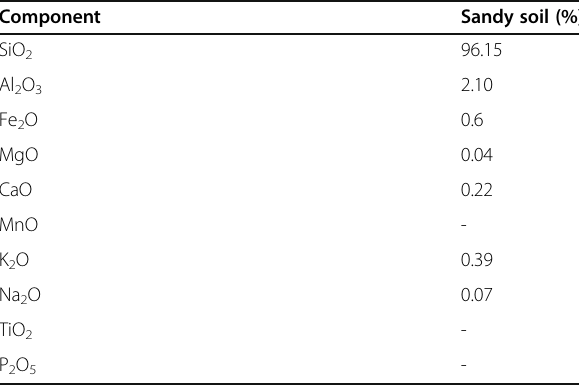
Table 2 Soil sample chemical